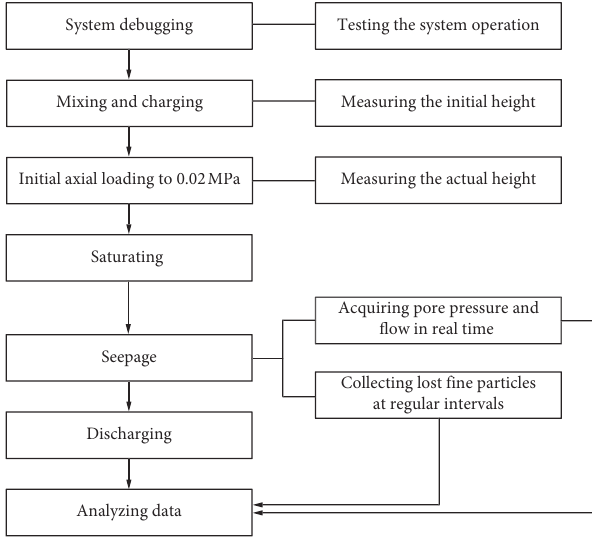
Figure 2: The test